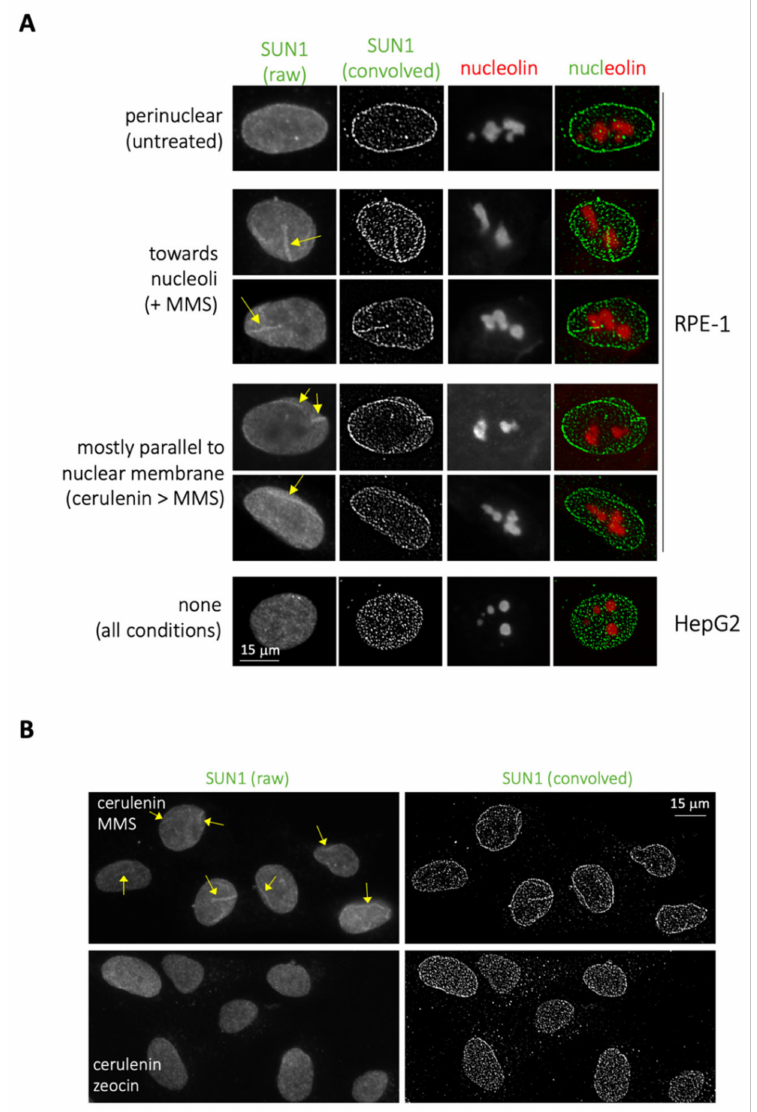
Figure 3. Increase in intranuclear membrane pools occurs in RPE-1 cells in response to MMS. ( A ) Immunofluorescence performed on RPE-1 and HepG2 cells to detect SUN1 and nucleolin signals. Visualization of membrane-associated SUN1 signals is enhanced by convolving the raw image. In RPE-1 cells, in untreated conditions, SUN1 signals are mostly perinuclear; in response to MMS, SUN1 invaginations reach nucleoli; preincubating the cells with cerulenin prior to MMS addition, SUN1 invaginations mainly run parallel to the nuclear membrane. In HepG2 cells, SUN1 antibody provided no membrane-associated pattern under these immunofluorescence conditions. ( B ) Immunofluores- cence to detect SUN1 performed on RPE-1 cells treated 4 h with 5 µ g/mL, the last 2 h either with additional 0.005% MMS or 100 µ g/mL zeocin. On the left, raw images are shown, and NR signals are indicated by yellow arrows. On the right, the same images were subjected to the ImageJ tool